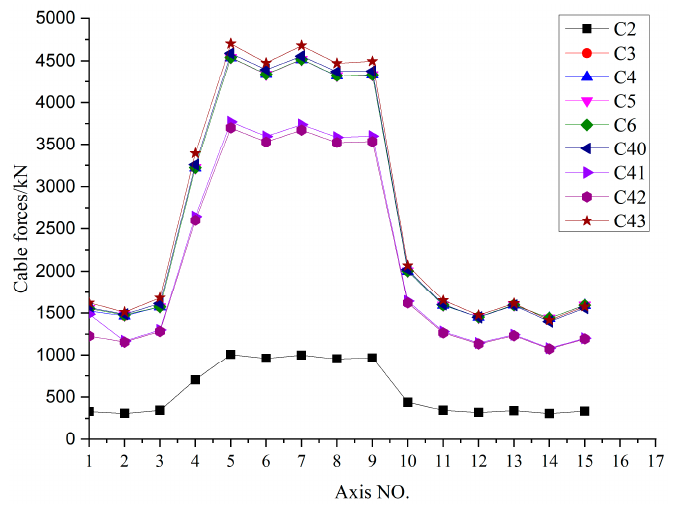
Figure 52. Cable force variation curve of three typical radial cables under various calculation conditions (kN).